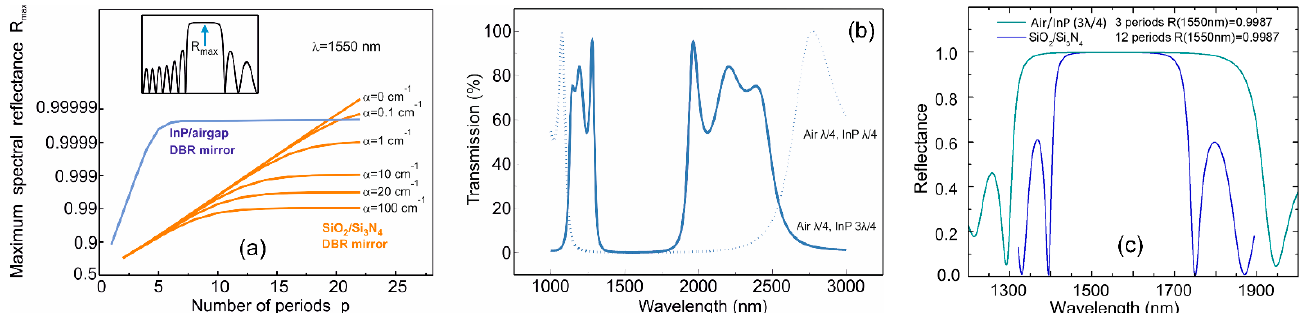
Figure 21. ( a ) Calculated maximum spectral reflectance R max for Si 3 N 4 /SiO 2 DBRs (orange) as a function of the number of periods p showing the absorption coefficient α as a variation parameter. In the case of the InP multiple air-gap DBRs (blue), α InP = 3.43 cm − 1 . The inset displays the calculated reflectance spectrum indicating the spectral position of the maximum spectral reflectance R max . ( b ) Transmission spectra for InP multiple air-gap DBRs. The dotted line shows a DBR structure including thinner InP layers ( λ InP /4) revealing a huge stopband of 1500 nm. The full line shows a structure including thicker InP layers (3 λ InP /4) revealing a smaller stopband of 500 nm. ( c ) Reflectance spectra for Si 3 N 4 /SiO 2 DBRs and InP multiple airgap DBRs.